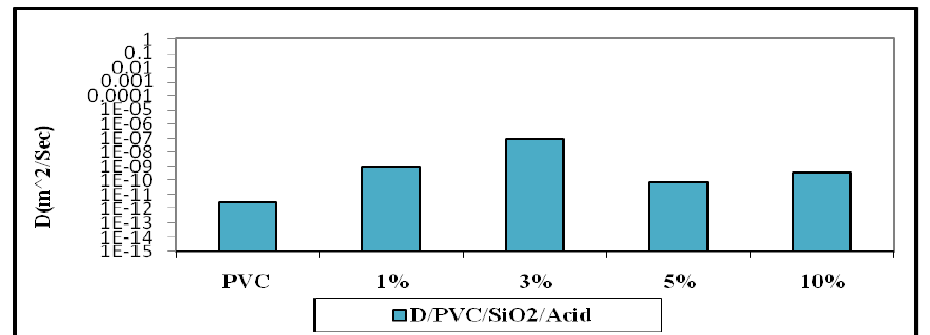
Fig. 10: Diffusion coefficient values versus wt. % of SiO